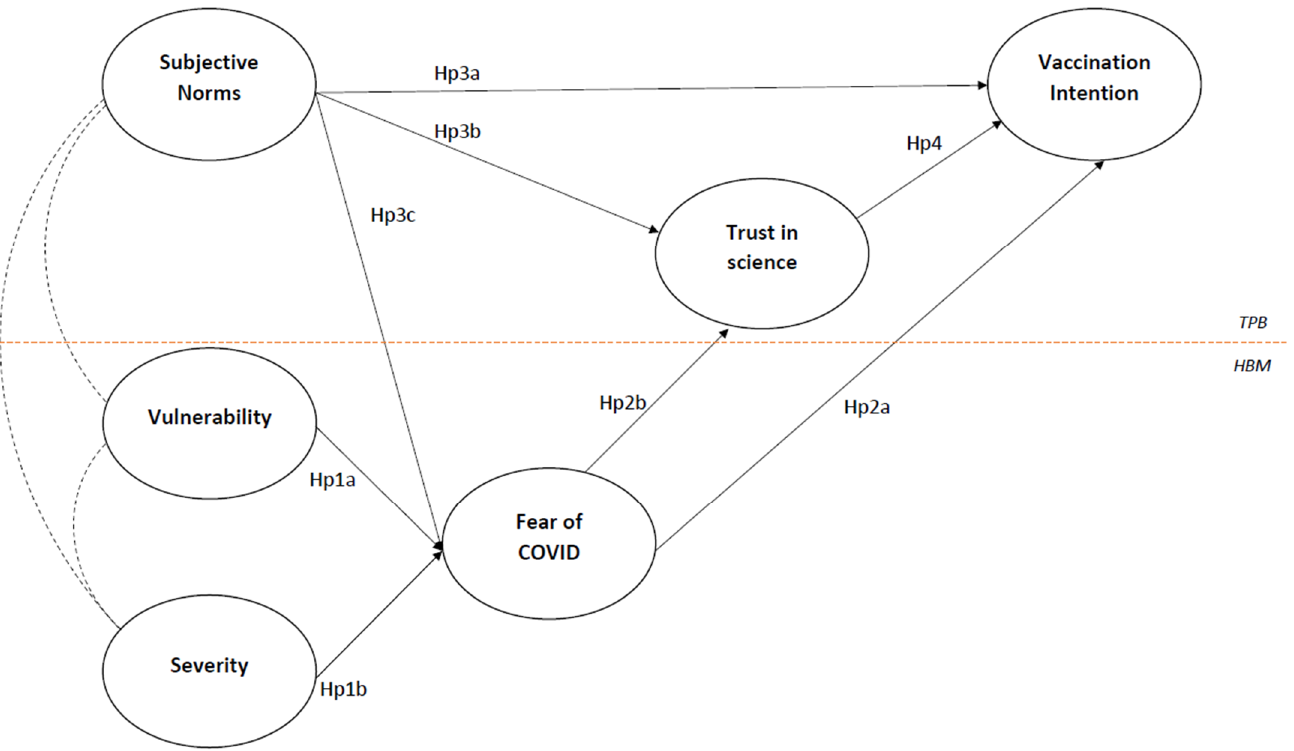
Figure 1. Hypothesized theoretical model.